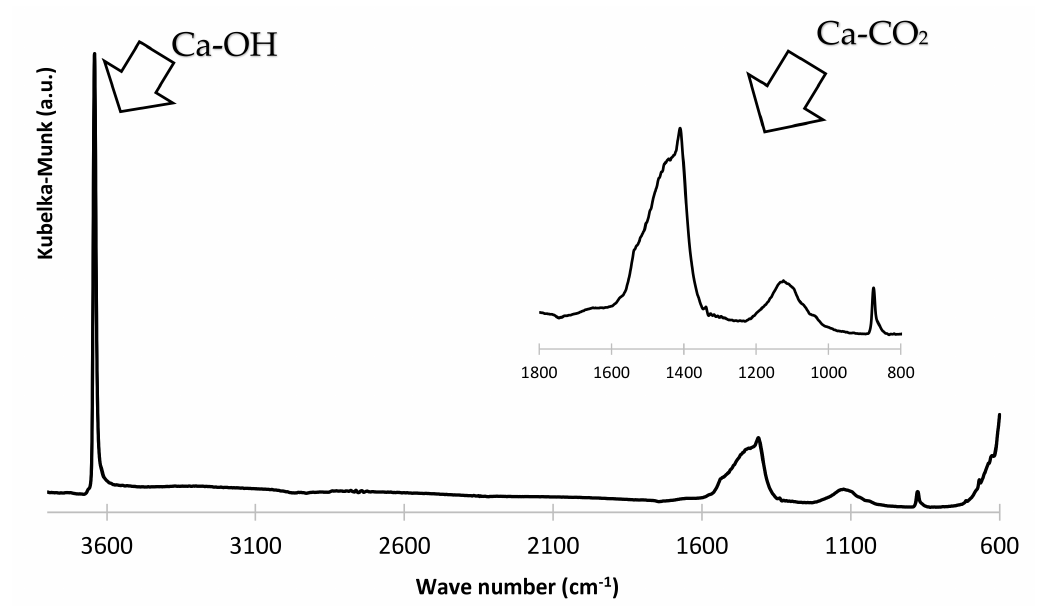
Figure 5. FTIR spectrum of the as-prepared catalyst (scallop shells calcined for 3 h at 800 ◦ C). Table 2. Energy consumed in rendering processes, fat yield, and fat